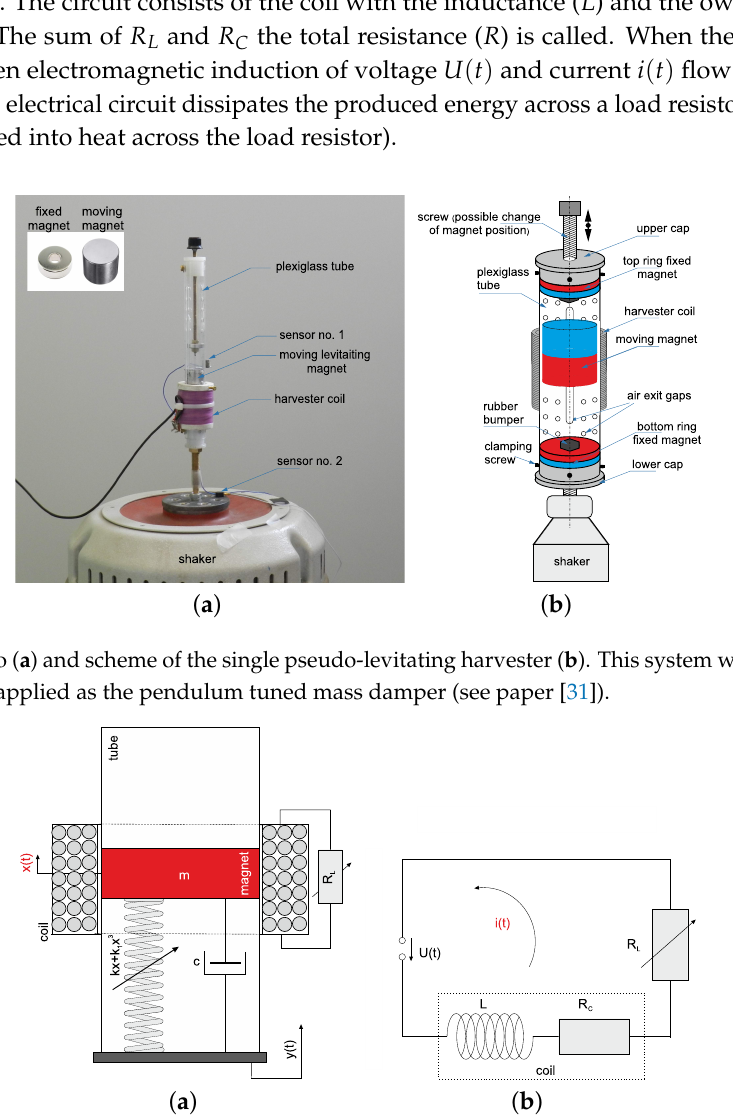
Figure 4. Physical model of pseudo-maglev harvester ( a ) and the electrical circuit comprising of the coil and the external load resistor ( b ). The magnet oscillation causes the current induction in the electrical